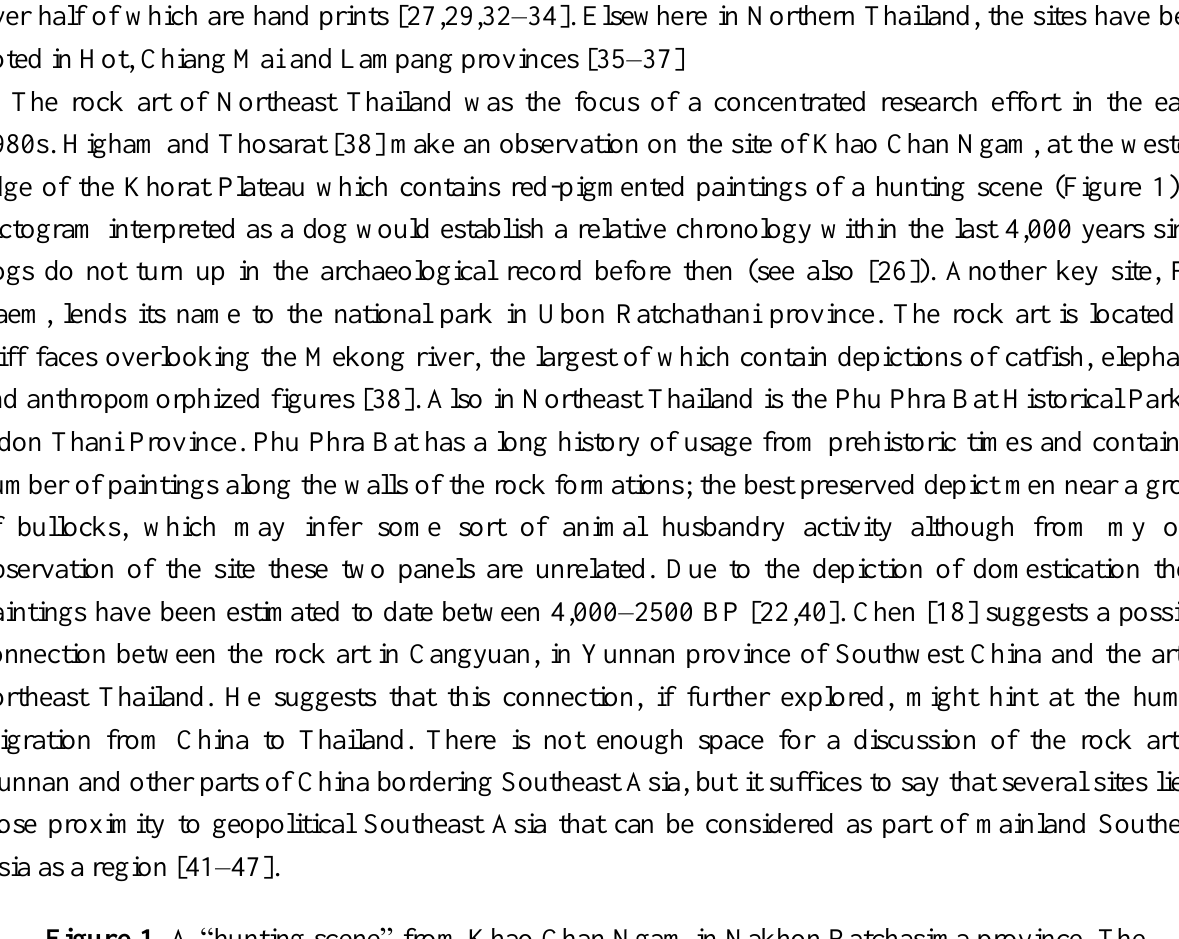
Figure 1. A “hunting scene” from Khao Chan Ngam in Nakhon Ratchasima province. The presence of a dog suggests that the rock art is less than 4,000 years old. Photo: Noel H.